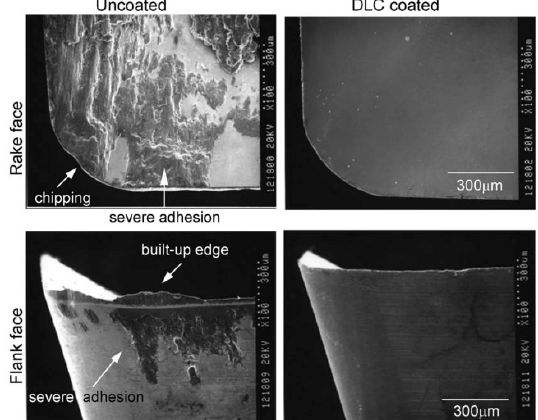
Figure 9. Scanning electron microscope (SEM) micrographs of the rake and flank face after the dry milling test for an AlCu 2.5 Si 18 alloy [110].